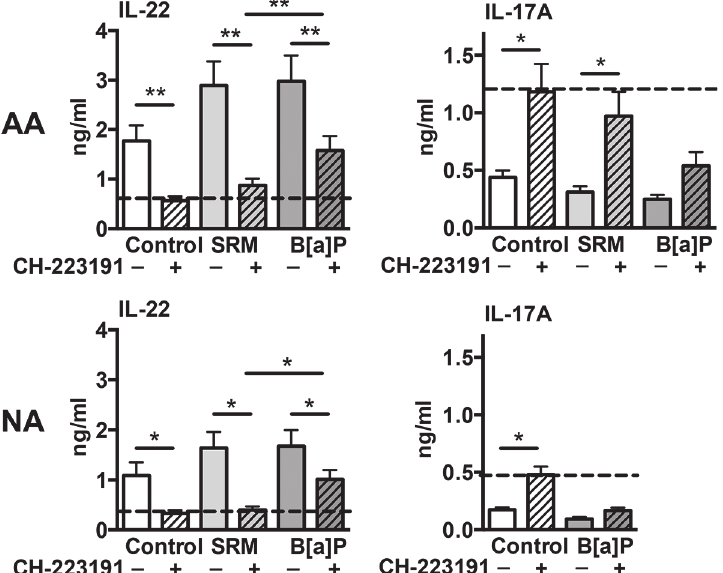
Fig 5. Effects of AhR antagonist on IL-22 and IL-17A secretion by peripheral blood mononuclear cells from Allergic asthmatics (AA) and nonallergic subjects (NA). Activated peripheral blood mononuclear cells from NA subjects (n = 10) and AA patients (n = 12) were incubated or not with PAH, in the presence or not of AhR antagonist CH-223191 for 72hr, and cytokine production was assessed by ELISA in the supernatants. Results are expressed as mean ± SEM. * P < .05, ** P < .01. The dotted line is set on the level of the antagonist-treated control cells.